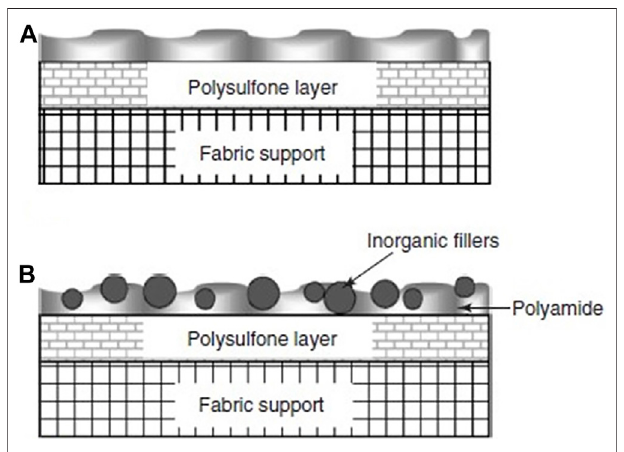
FIGURE 2 | Conceptual illustration of PA (A) TFC and (B) TFN membrane structures (Zhou et al., 2009).